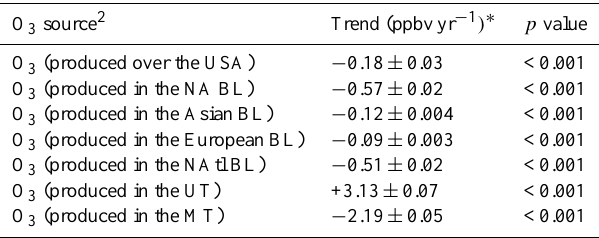
Table 5. Trends in contributions to O 3 at PMO from various regions and sources 1